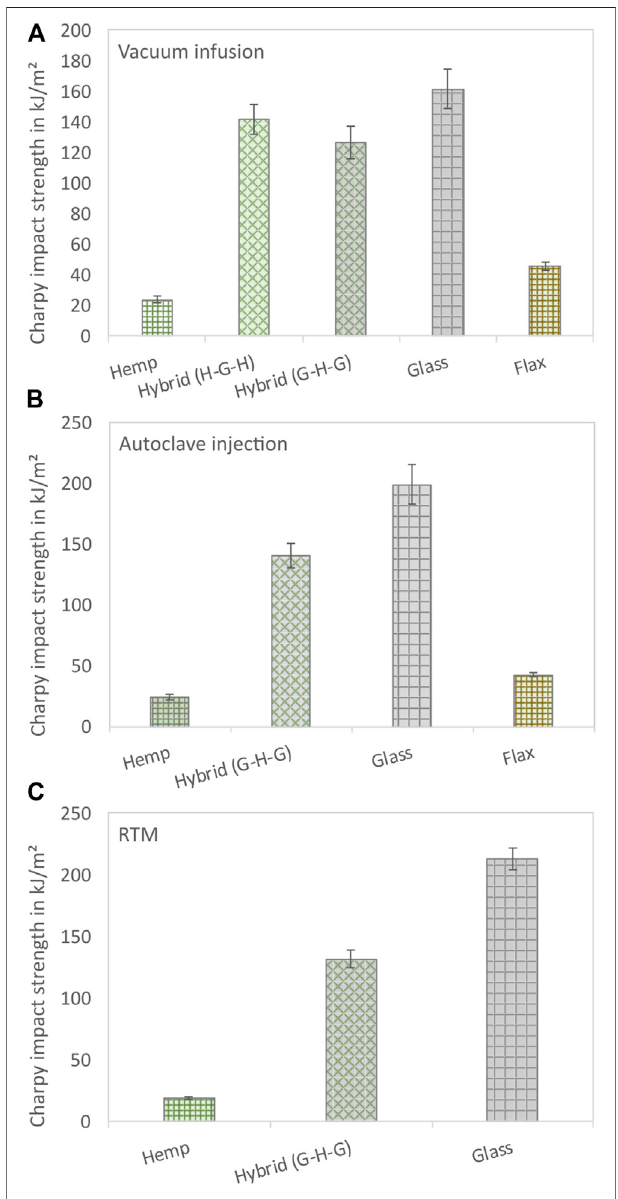
FIGURE 11 | Unnotched Charpy impact strength (mean value ± standard deviation)of compositelaminates produced byvacuum infusion (A) , autoclave injection (B) and RTM (C)